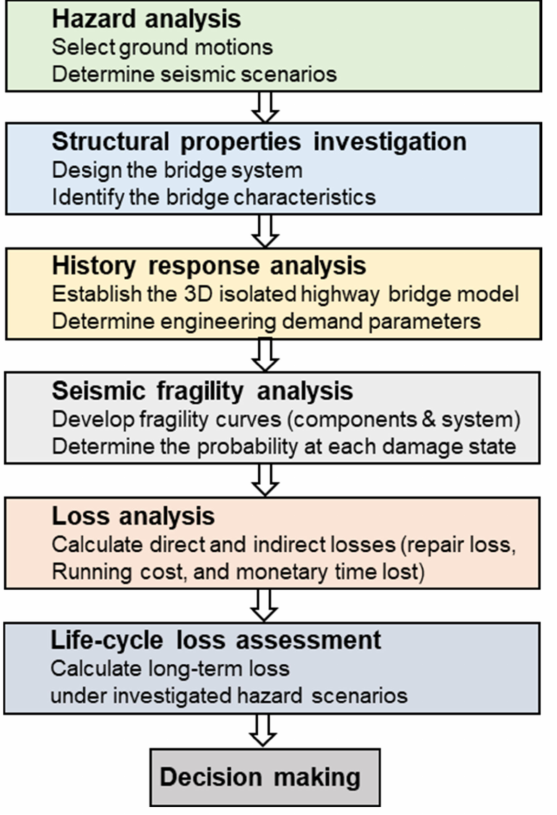
Figure 4. Flowchart of the performance-based life-cycle assessment of bridge systems under seismic